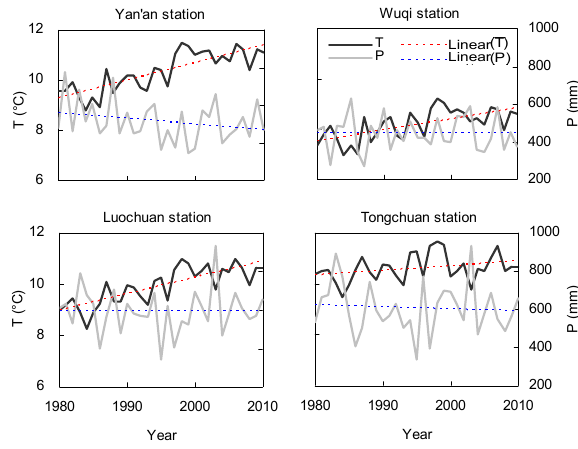
Fig. 2. The variations of annual mean temperature ( T ) and precip- itation ( P ) at the four meteorological stations from 1980 to 2010. The dotted lines are linear trends for T in red and P in blue, respec- tively. The trends are all significant for T except for the Tongchuan station and insignificant for P for all the stations ( p <